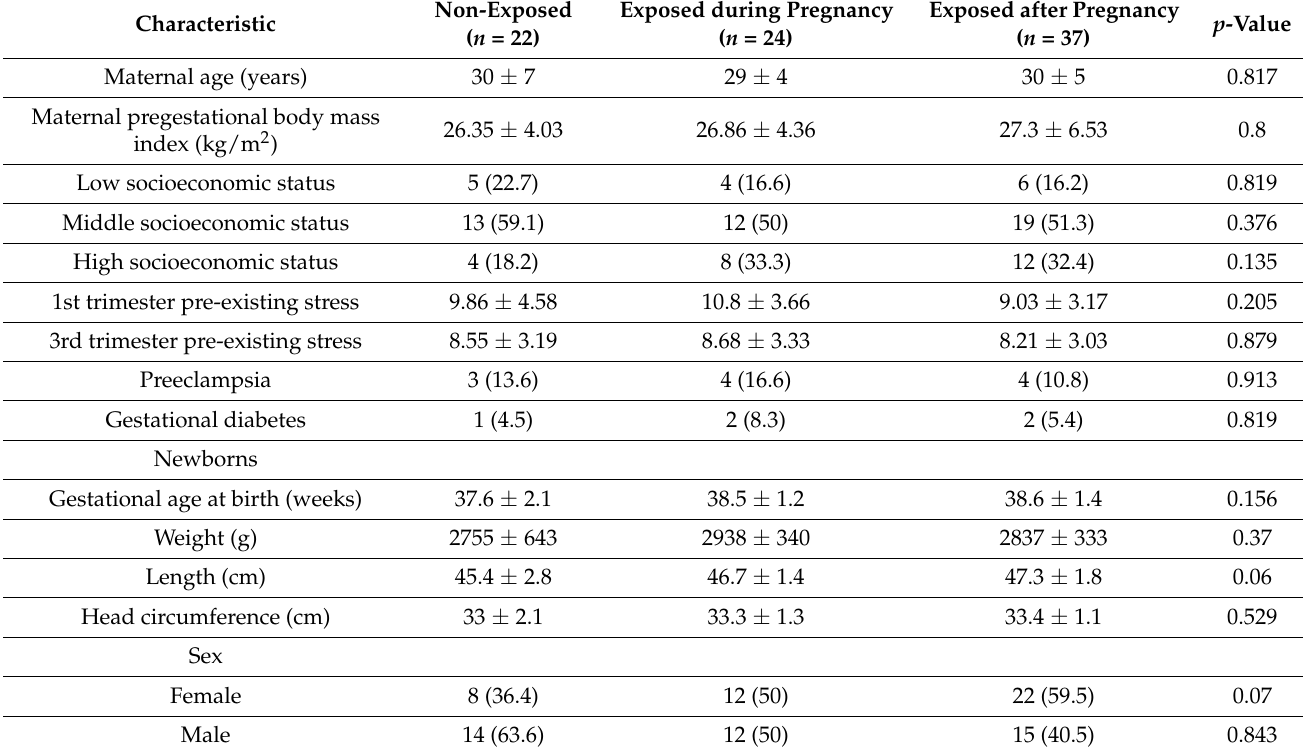
Table 1. Characteristics of pregnant women and newborns exposed and non-exposed to the earthquake. Characteristic